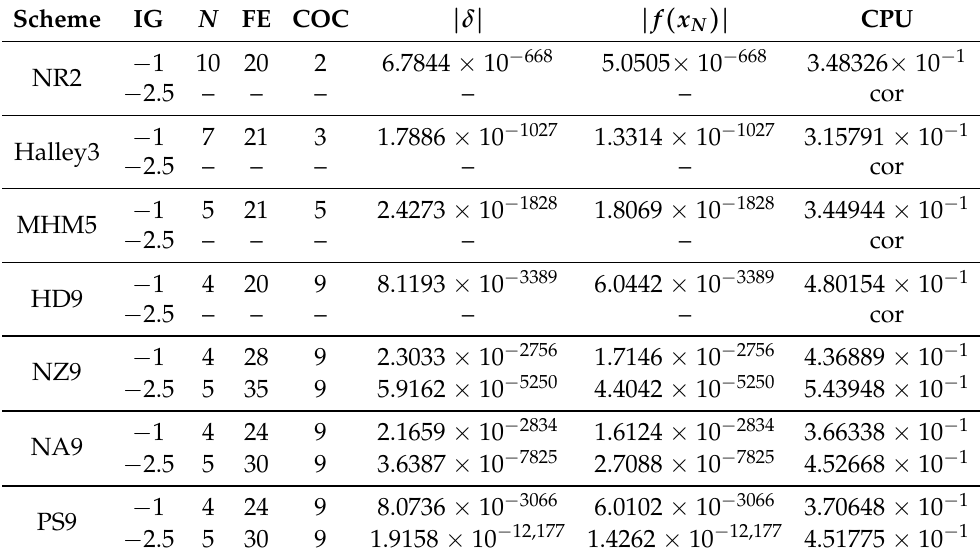
Table 3. Numerical results for problem 2 ( f 1 ( x )) with two different initial